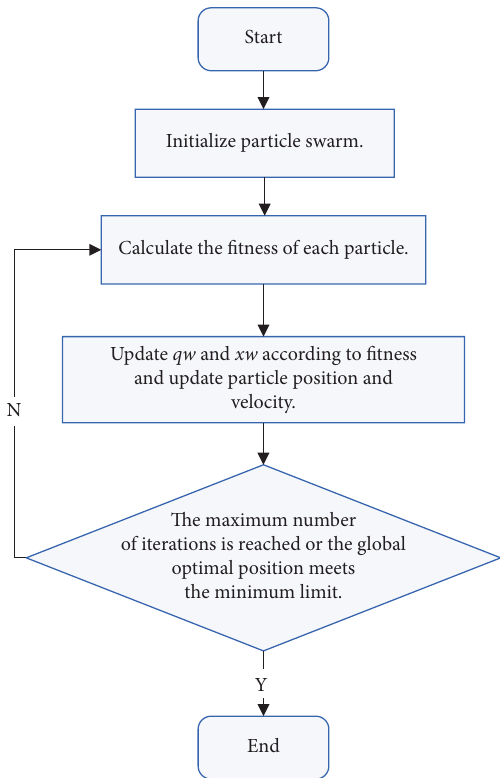
Figure 3: Flowchart of